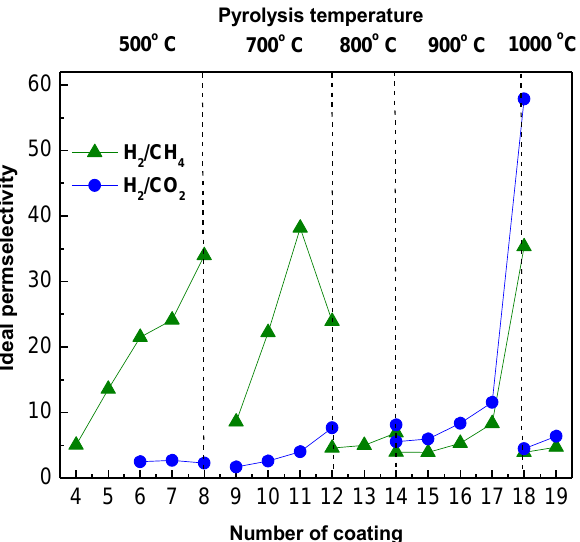
Figure 12. Corresponding H 2 / CO 2 and H 2 / CH 4 ideal selectivities for the results of Figure 11, C2-Fe membrane.